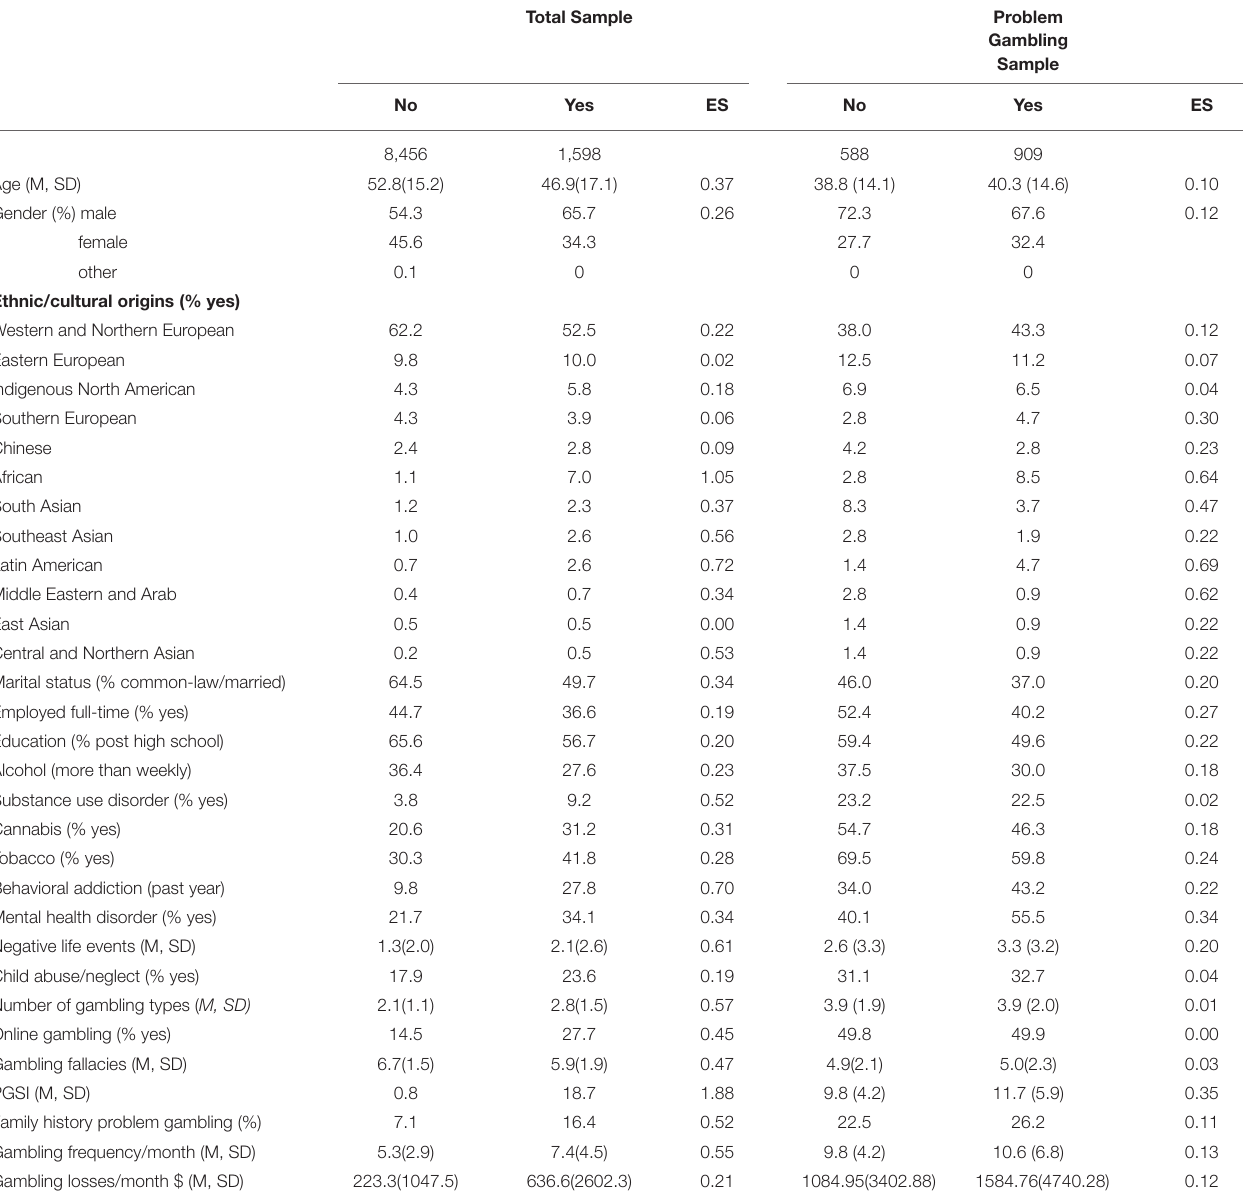
TABLE 1 | Who makes change attempts among people who gamble and people with gambling problems?.